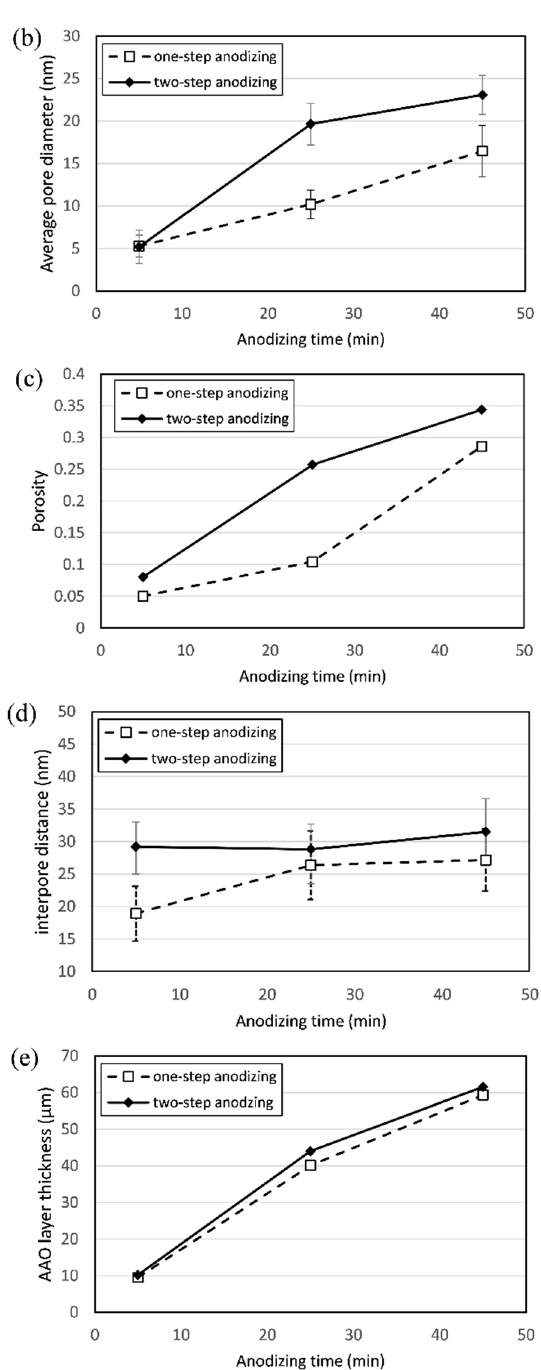
Figure 4. ( a ) SEM images of the top of the AAO film produced by one-step and two-step anodizing at an applied voltage of 20 V for 5 and 45 min (scale bar 200 nm), and the ( b ) average pore diameter, ( c ) porosity, ( d ) interpore distance and ( e ) is film thickness after 5, 25, and 45 min of